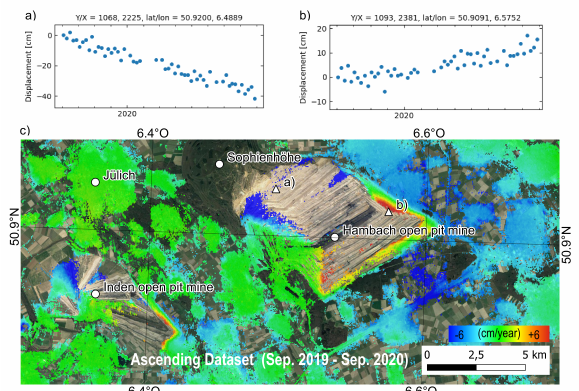
Figure 2. Mining induced deformation at the Rhenish coal fields (Germany) derived from Sentinel-1 ascending track images for the period September 2019 to September 2020. a) and b) depict exemplary LOS displacement time series in c). c) shows the average displacement velocity map along the LOS direction; white triangles indicate the locations of the plotted time series in a) and b). A coherence mask greater than 0.7 was applied. Background imagery for c) Google Earth GeoBasis-DE/BKG, Map data